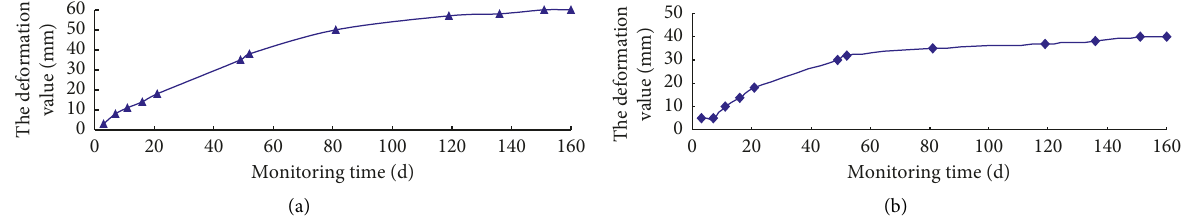
Figure 9: Displacement curves of surrounding rock. (a) Convergence between roof and floor. (b) Convergence between two sides.